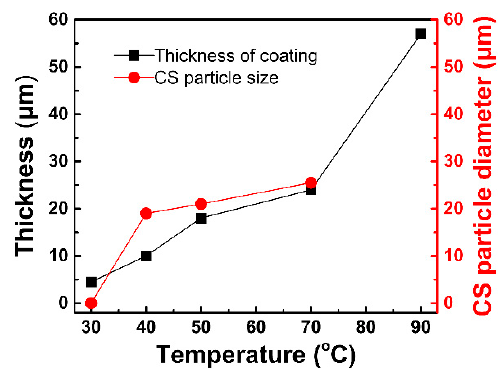
Figure 4. Coating thickness and chrysanthemum-shaped (CS) particle size plotted as a function of temperature.